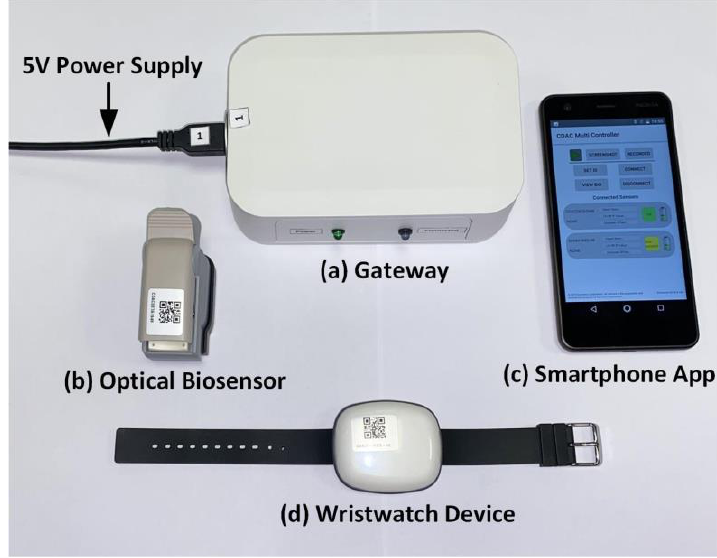
Figure 18. Clinical trial test devices.